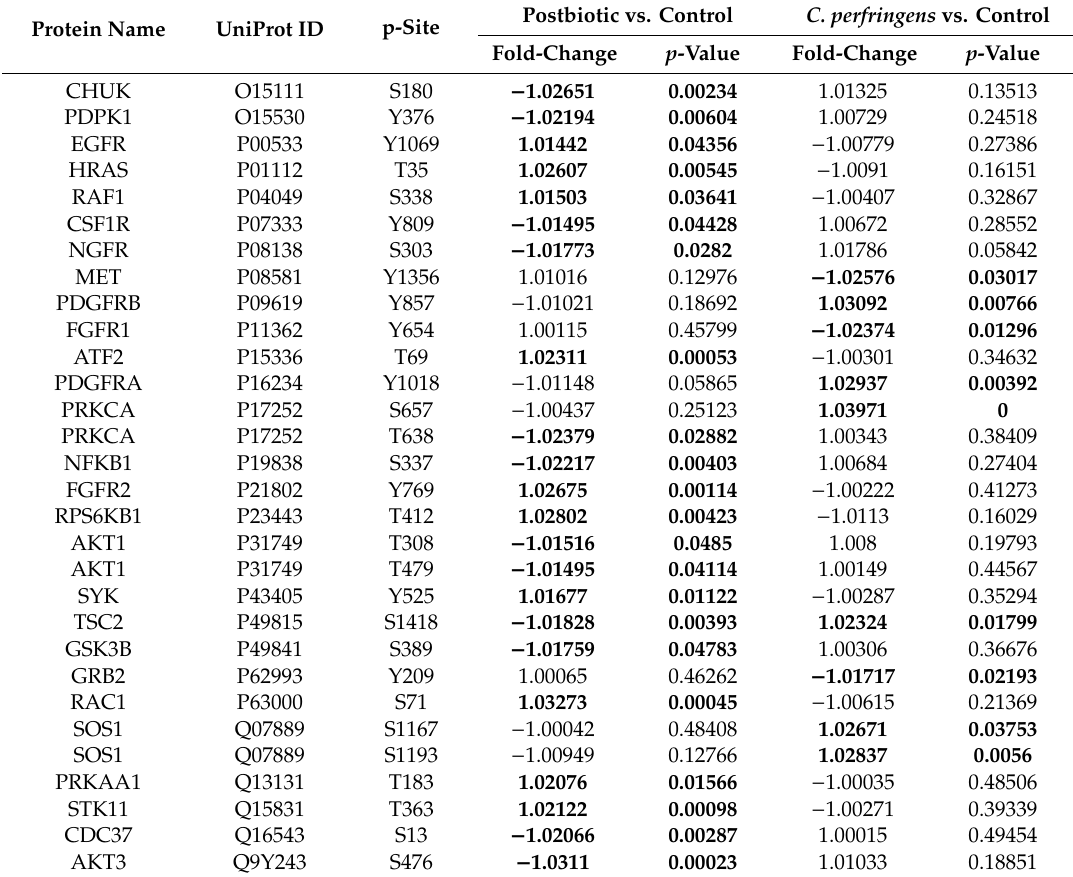
Table 10. Members of the PI3K-Akt signaling pathway showing di ff erential phosphorylation in jejunal